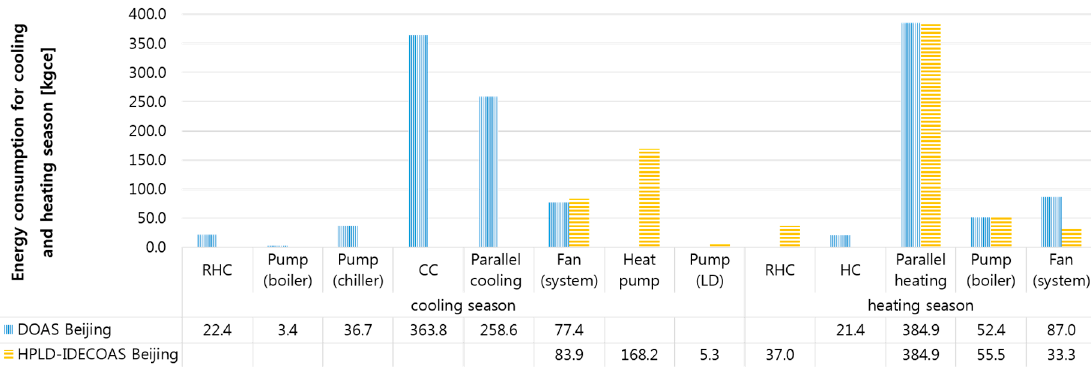
Figure 18. Comparison of monthly energy consumption in Lhasa.